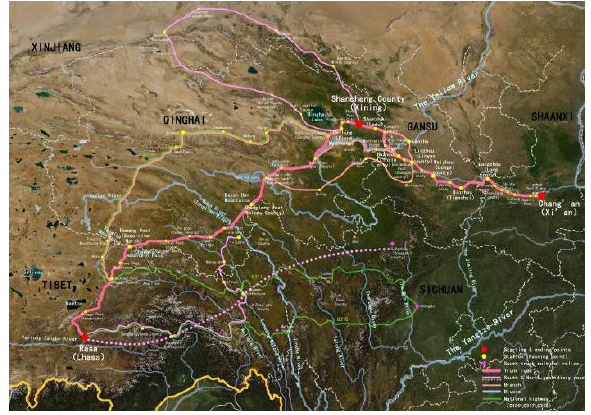
Figure 5. Trunk road, subsidiary road and branch of Tang-Tibet